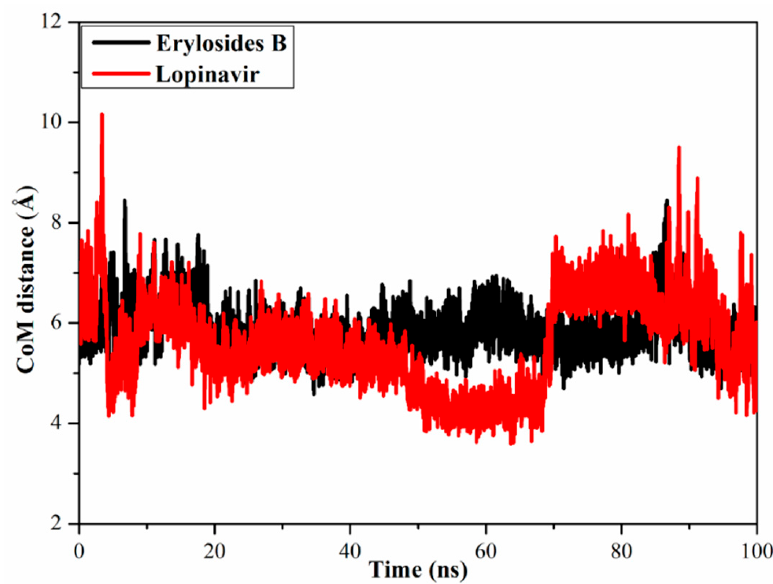
Figure 6. Center-of-mass (CoM) distances (in Å) between erylosides B (black) and lopinavir (red) and GLN189 of M pro over a 100 ns MD simulation.